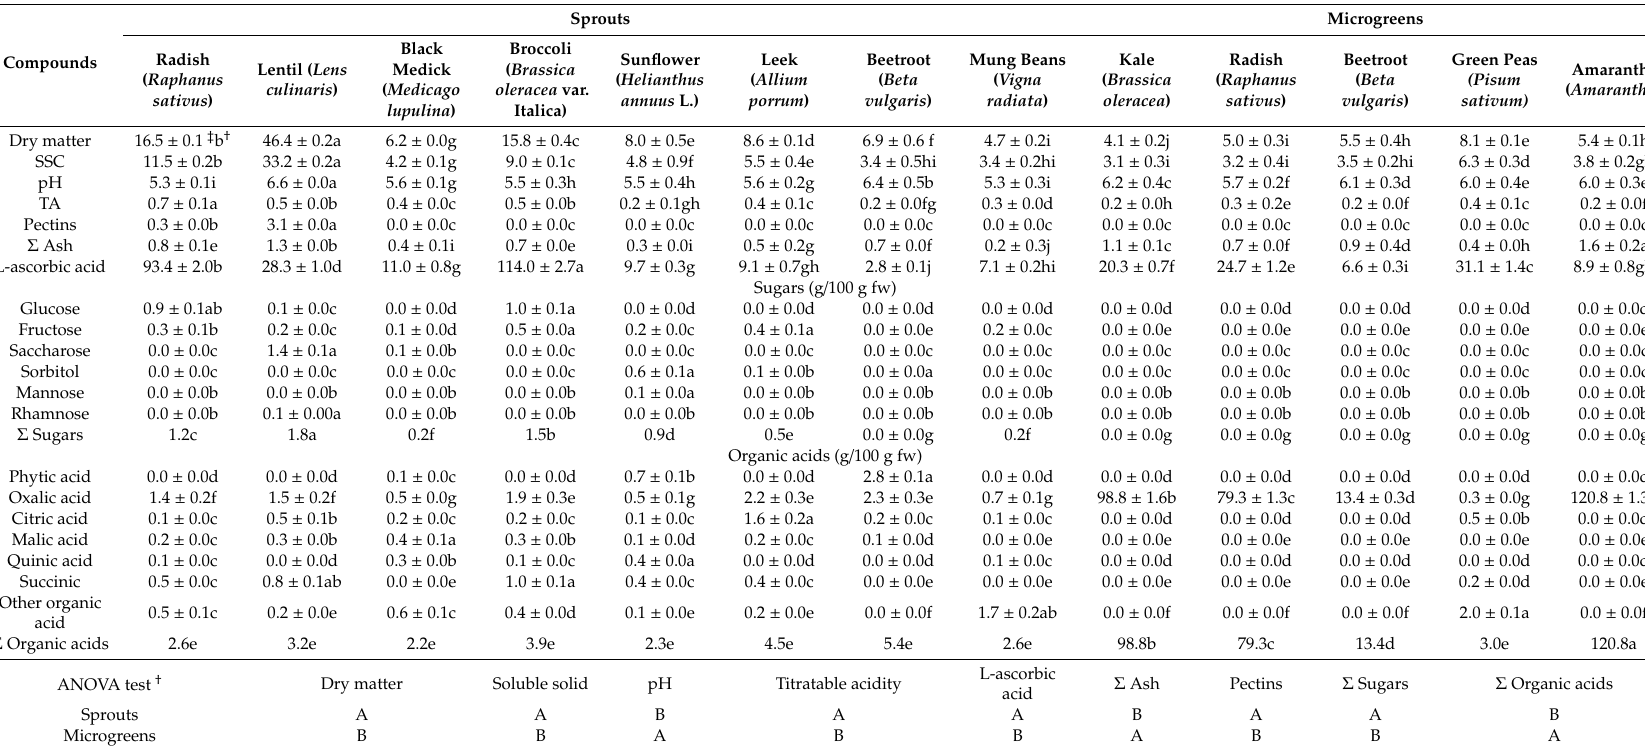
Table 1. Basic chemical composition (dry matter, pH, titratable acidity, pectins, ash), L-ascorbic acid, sugars and organic acids of sprouts and microgreens.